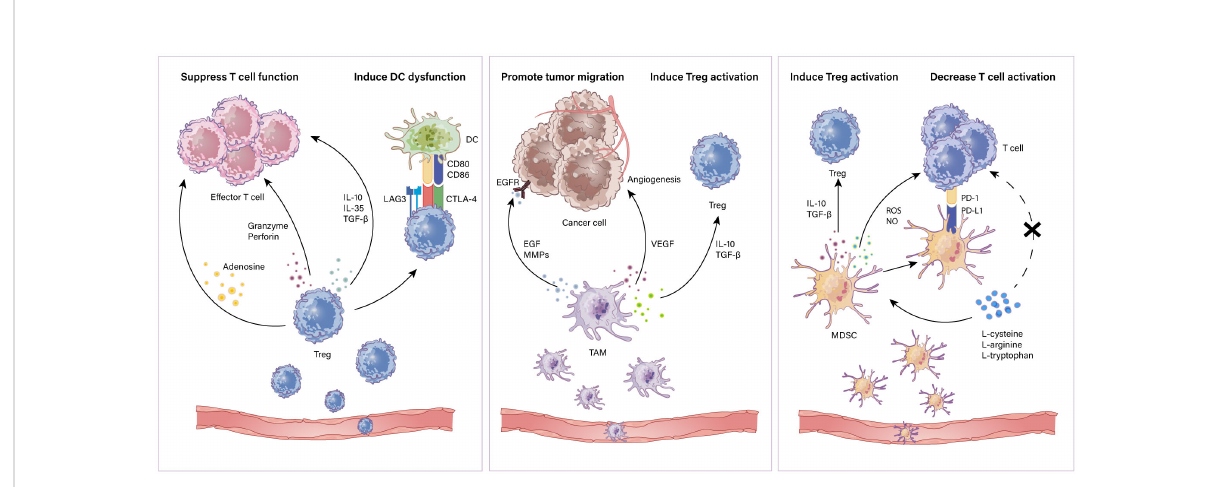
FIGURE 1 Immunosuppressive cells in the TME. Immune suppressive cells mainly contain Tregs, TAMs and MDSCs. Tregs restrain antitumor effector T cells including (i) secretion of repressive cytokines such as IL-10, IL-35 and TGF- b ; (ii)induction of cytolysis via releasing granzymes and perforins; (iii) metabolic disturbance through adenosine production. Also, Tregs induce antigen presenting cell dysfunction for a tolerant phenotype. TAMs can (i) secrete EGF and MMPs to promote tumor progression; (ii) produce VEGF to aid in tumor angiogenesis; (iii) secrete IL-10 and TGF- b to induce Treg activation. MDSCs suppress T cells through (i) secretion of IL-10 and TGF- b which induce Tregs; (ii) production of NO and ROS which induce cytolysis and inhibit T cell activation; (iii) depletion of essential amino acids which play a crucial role in T cell activation and